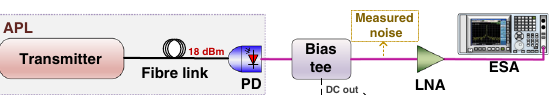
NF-optimized HCF APL noise fi gure measurement experiment shown in Fig. 5 20 dBm of CW light power at 1550 nm from a DFB laser diode was ampli fi ed to 27 dBm using an EDFA. Then the ampli fi ed signal was modulated using a 20 GHz band- width MZM biased at its low-biasing point. The output light with a power of 12 dBm was ampli fi ed by another